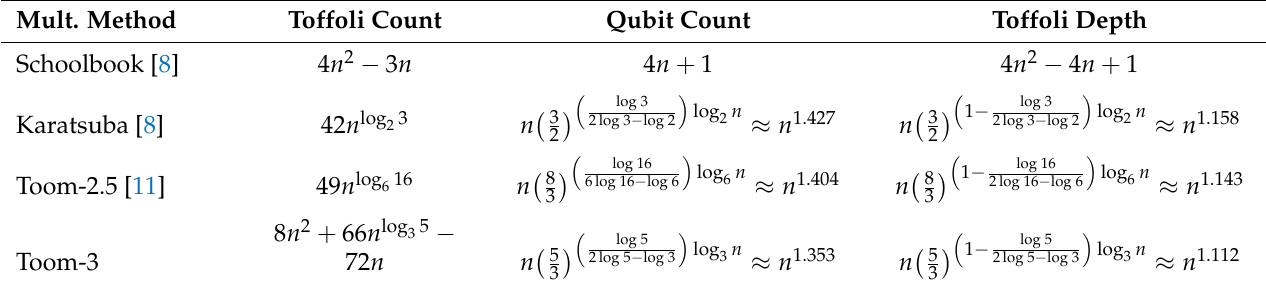
Table 1. Complexity of Several Quantum Multiplication Methods.